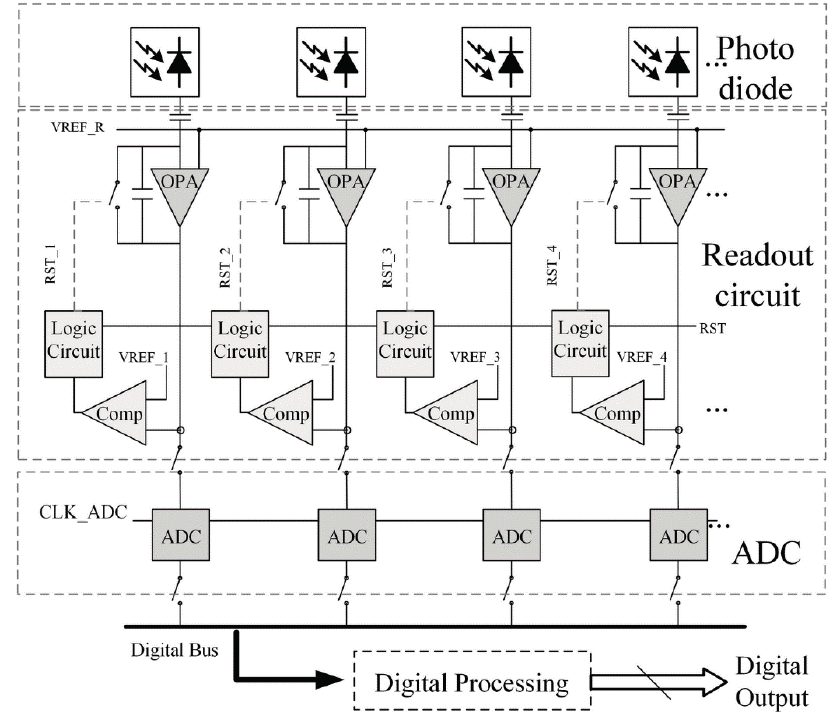
Figure 1. Block diagram of a linear image